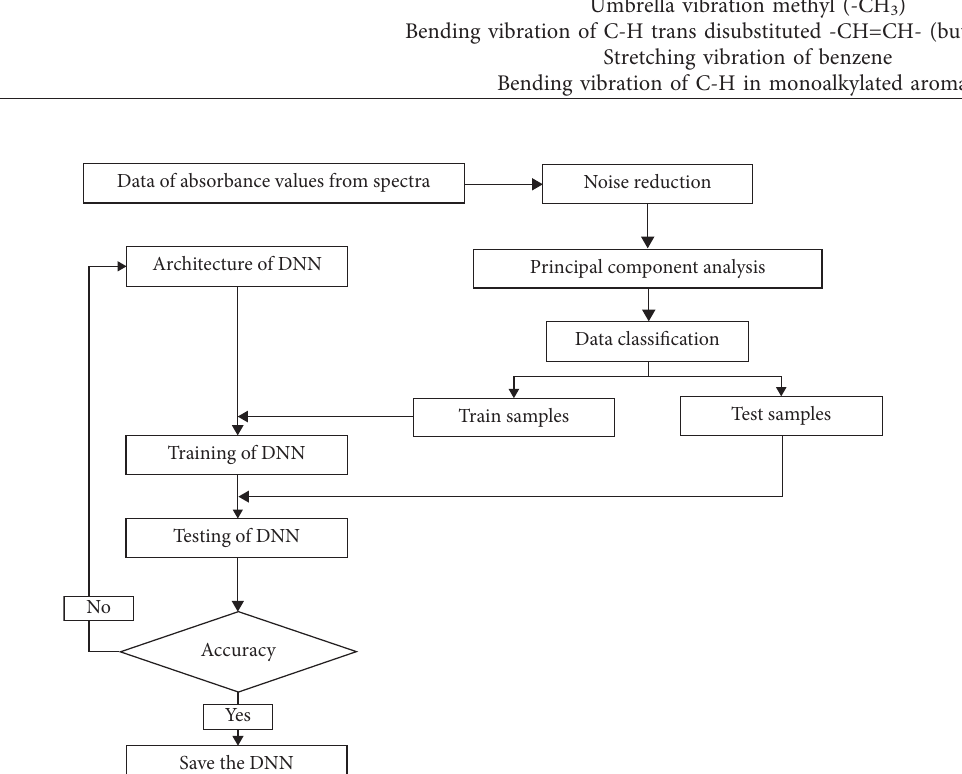
Figure 5: Process of developing a